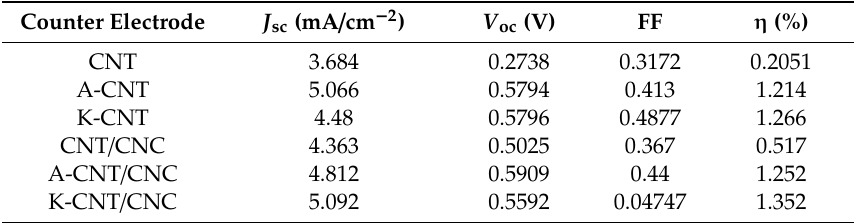
Table 1. Photocurrent–voltage ( J – V ) curve characteristics of dye-sensitized solar cells (DSSCs) with various counter